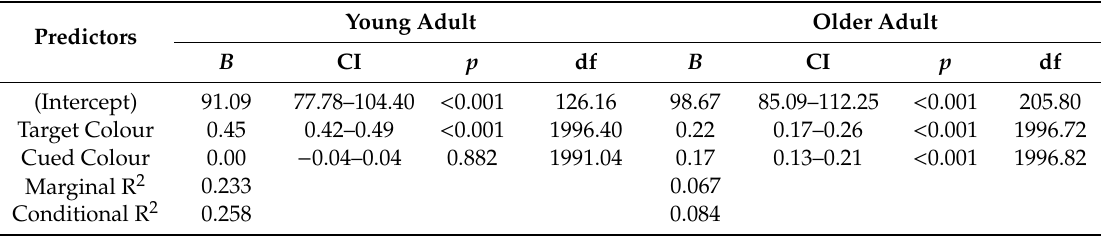
Figure 3. Uncued responses made towards the cued colour for young and older adults. Erroneous responses to the cued item should fall on the diagonal, and a linear trend would suggest a tendency to report the cued item in place of the uncued probe, as is apparent in the older group. Table 3. Linear mixed-effects model.